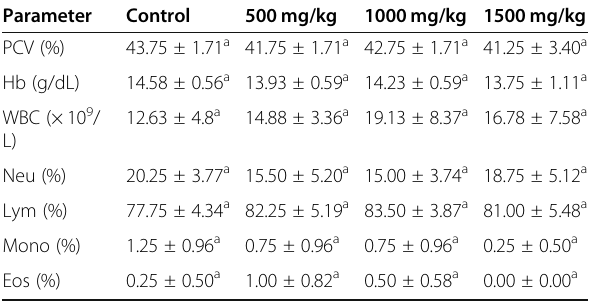
Table 1 Effect of aqueous extract of Spondias purpurea leaf on hematological parameters in rats Parameter